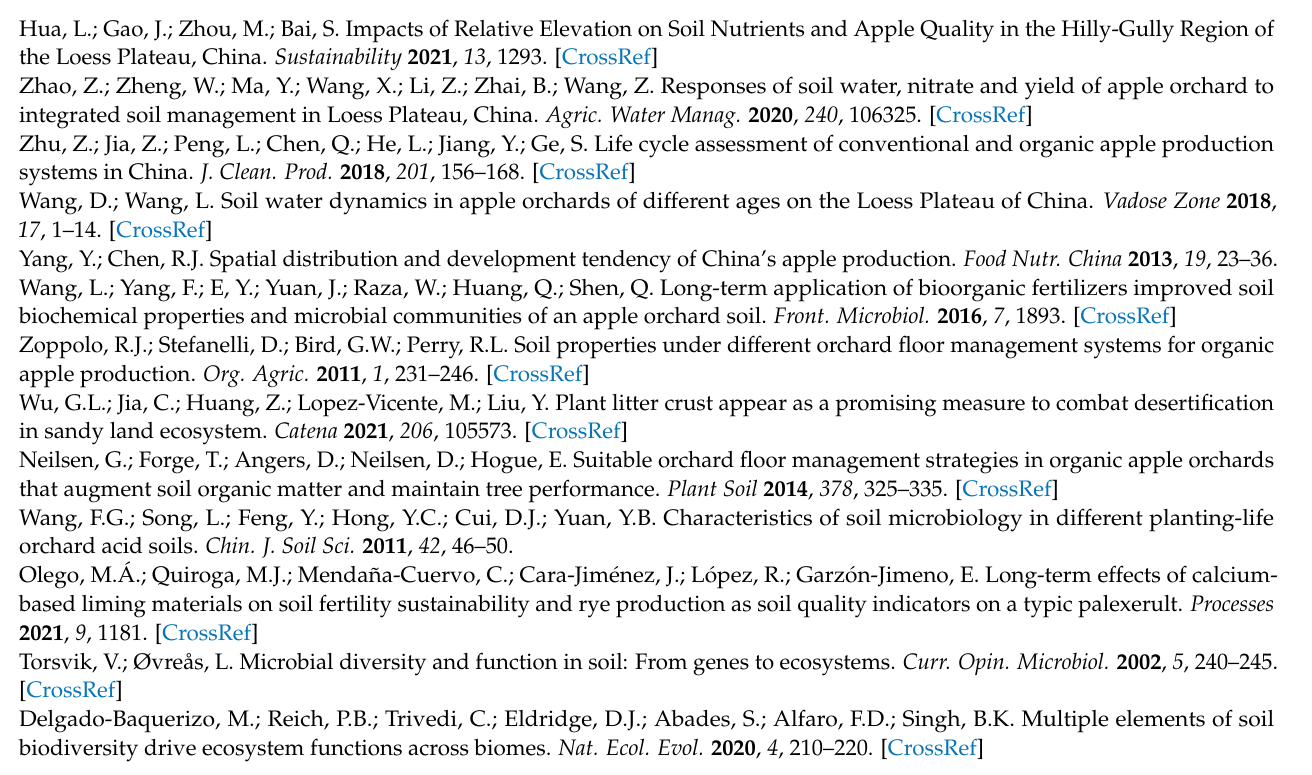
(B) Rank abundance curve in the treatments with and without biochar, different color line represents different treatments. Figure. S2: (A) ACE and (B) Simpson index of OTUs for soil samples where biochar was applied. Figure. S3: The UniFrac-based hierarchical cluster analysis of all treatments. Figure. S4: The dbRDA analysis is a distance-based redundancy analysis, which is suitable for any distance